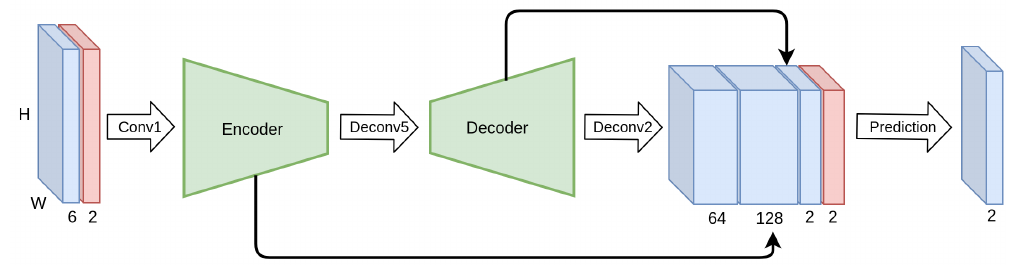
Figure 12. Overview of the modified FlowNet S architecture with added CoordConv modules. Grid coordinates (red) are concatenated before the first and last